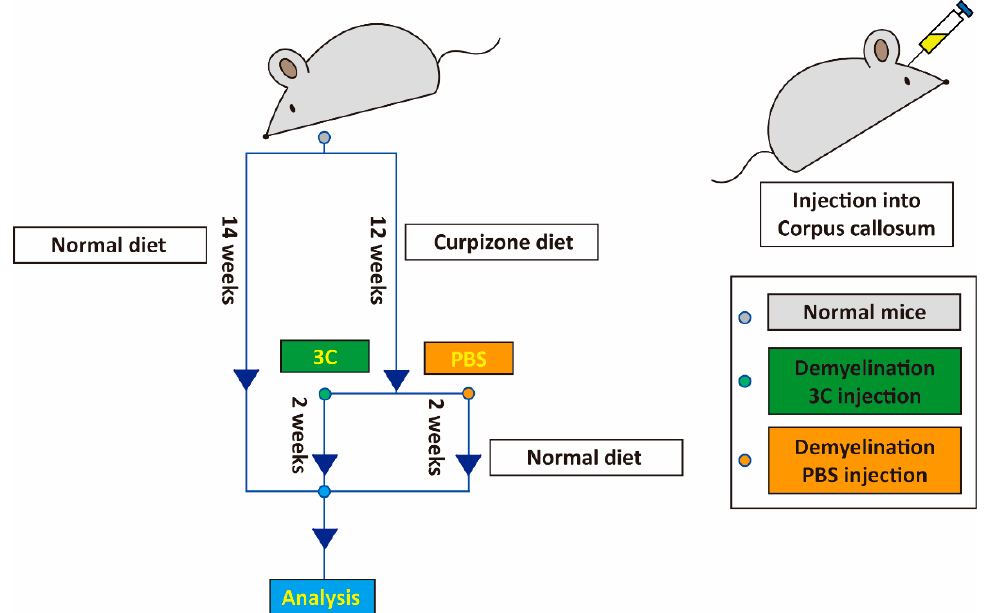
Figure 5. Sketch of remyelination improvement with injected 3-chemical (3C) cocktail into a cuprizone-induced-demyelination mouse model. The flow chart shows that the 3C cocktail (Y27632, SU9516, and FSK) and PBS were injected into mice in the corpus callosum after 12 weeks of cuprizone-induced demyelination. After 2 weeks of recovery, 3C cocktail (Y27632, SU9516, and FSK) injection groups, PBS injection groups, and positive control groups (normal diet) were sacrificed for the follow-up analysis.